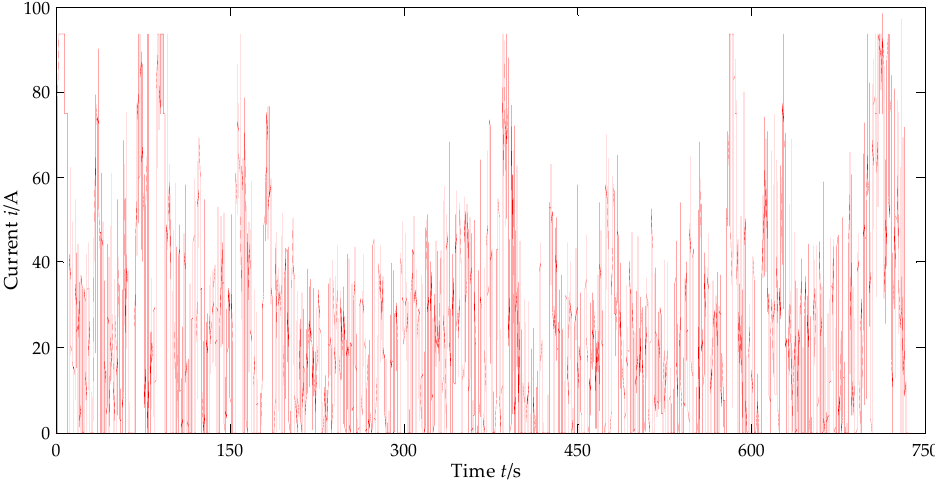
Figure 10. The optimized output current of vehicle power supply.